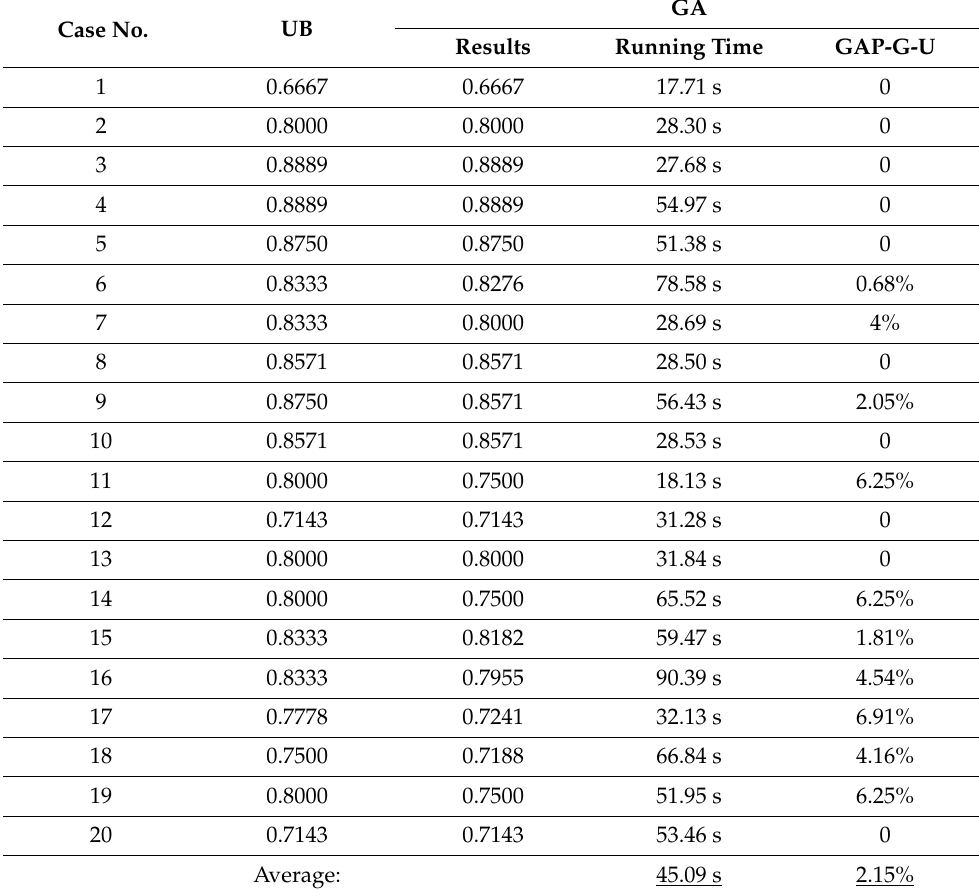
Table 3. Comparison results. Case No.